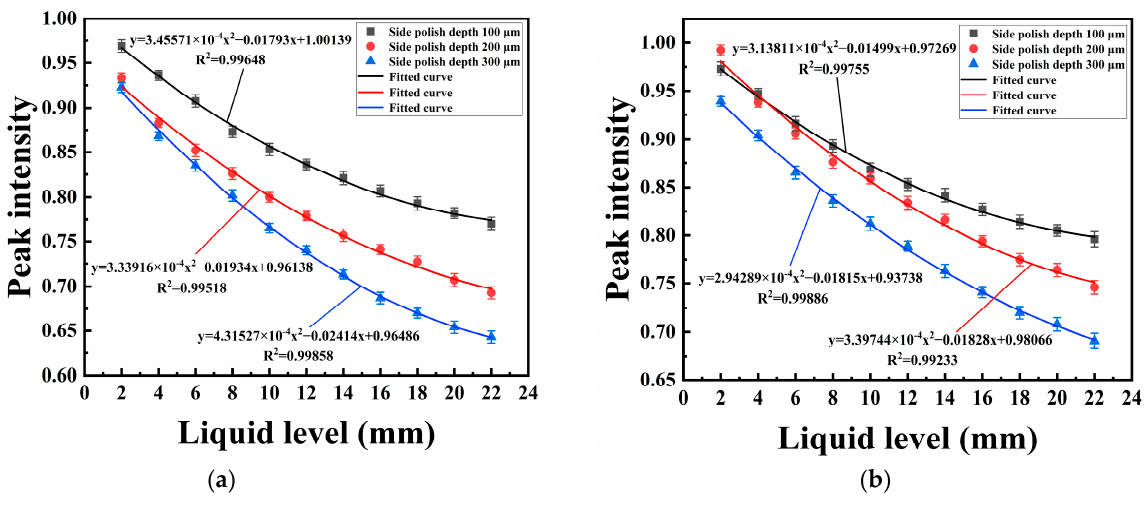
Figure 9. Liquid-level sensing performance of probes with different polished depths in liquids with RIs of 1.335 ( a ) and 1.38 ( b ).